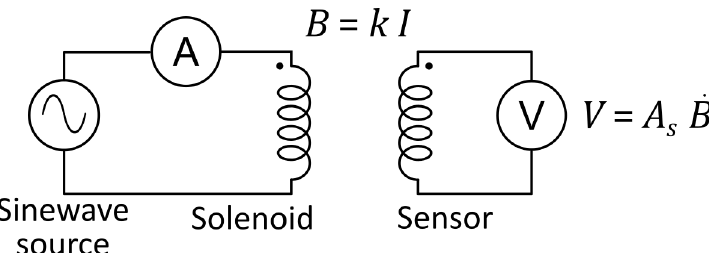
Figure 3. Schematic of the basic principle of the